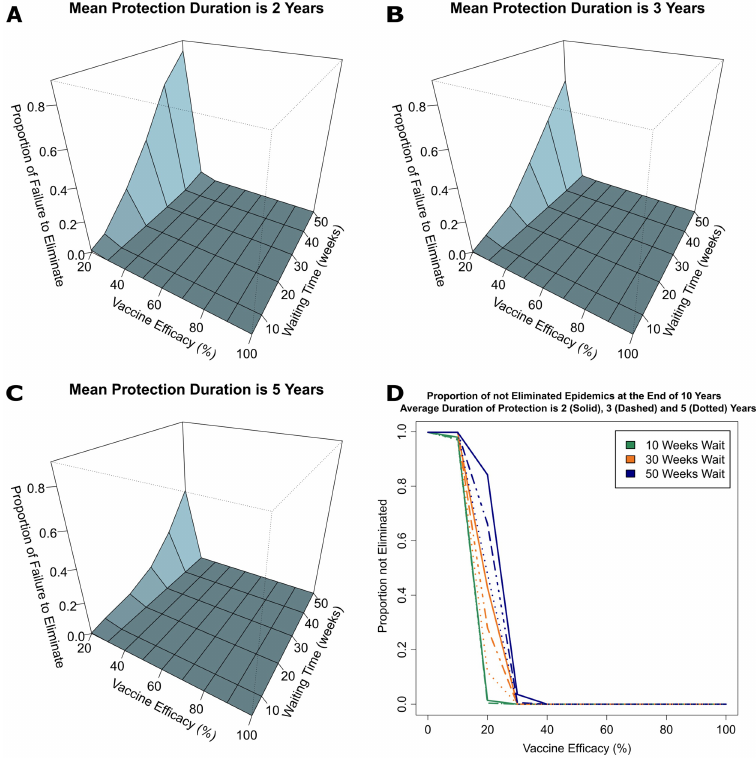
Fig 6. The proportionof failure to eliminatecholera transmission amongall simulatedepidemics for parameter settings definedas combinations of vaccine efficacy (20-100%with 10% increments) and the averagewaiting time to be vaccinated(5, 10, 20, 30, 40 and 50 weeks) are presented, stratified by the averagedurationof immunity after vaccination of 2 (A), 3 (B), and 5 (C) years. Panel (D) shows slices of the three-dimensionalplots at 10, 30, and 50 weeks for the averagewaitingtime to be vaccinated.Proportions of failure to eliminatehigherthan 0.8 are truncatedat 0.8 in panels (A)-(C) but are shown in panel (D).